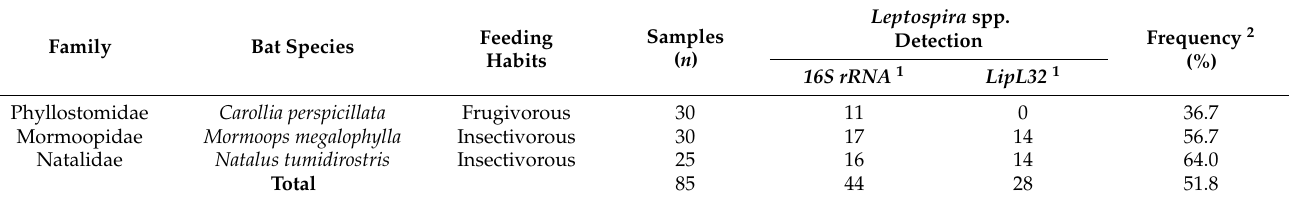
Table 2. Leptospira spp. detection according to bat